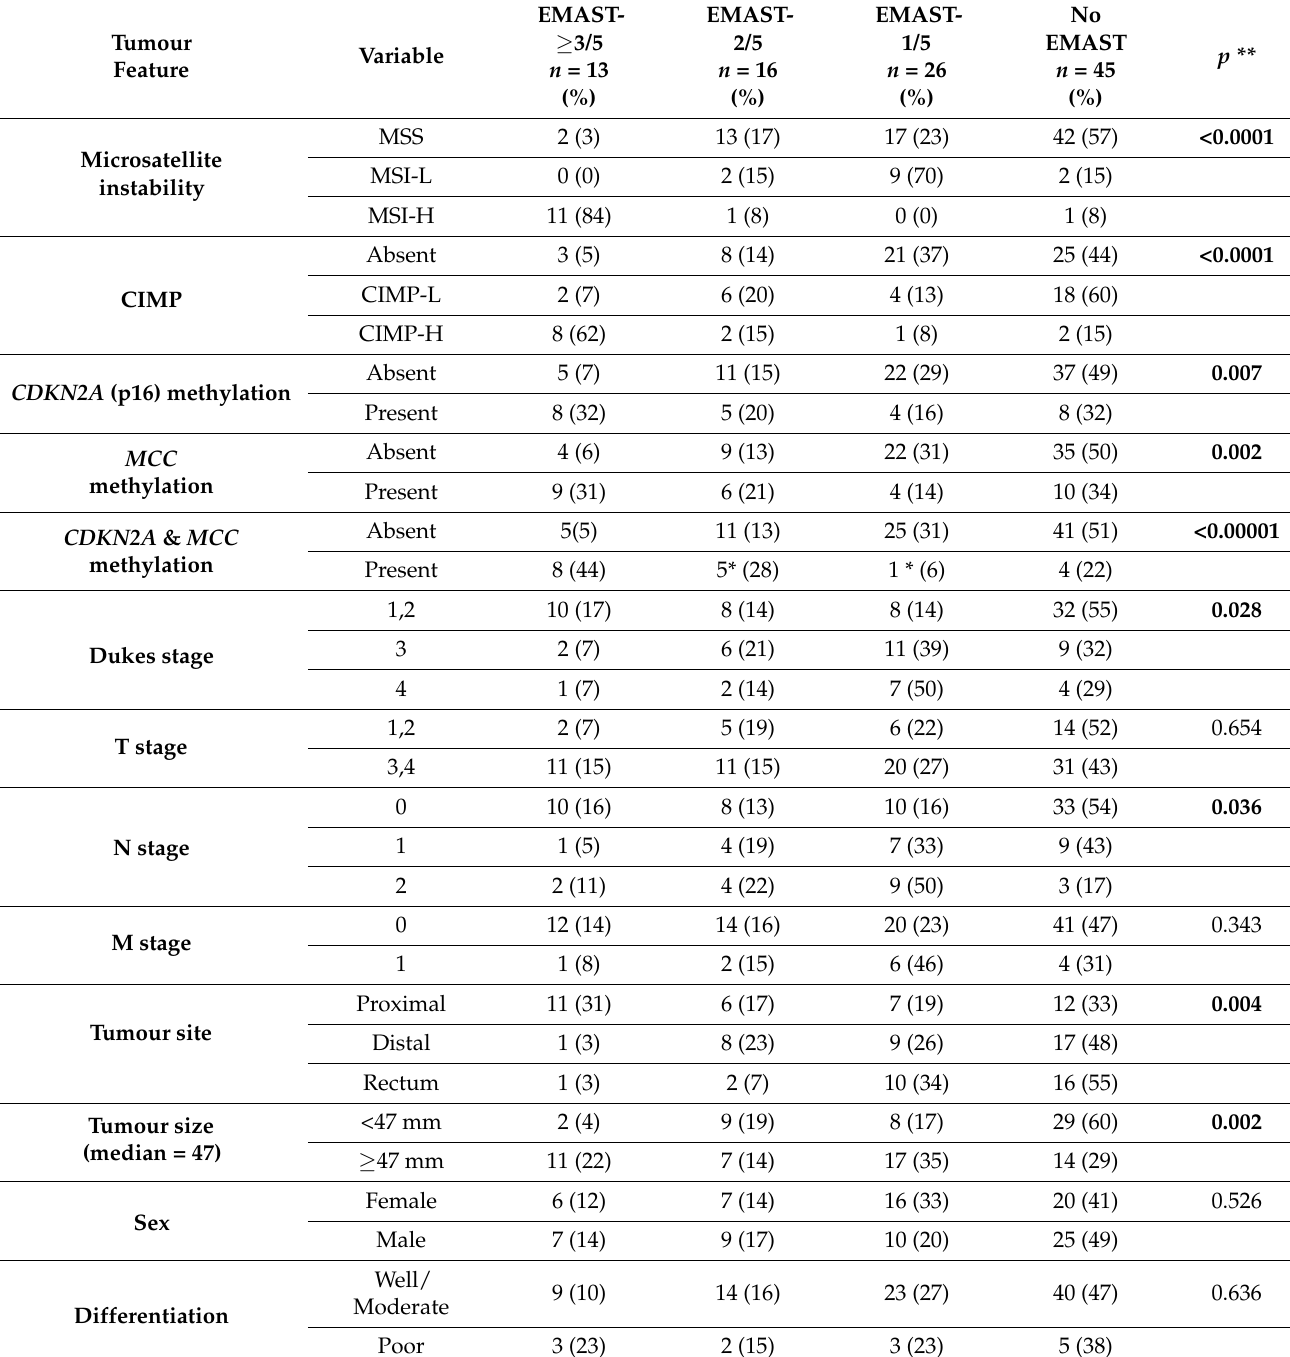
Table 1. Association of EMAST with clinicopathological features and molecular markers in colorectal cancer from cohort 1.